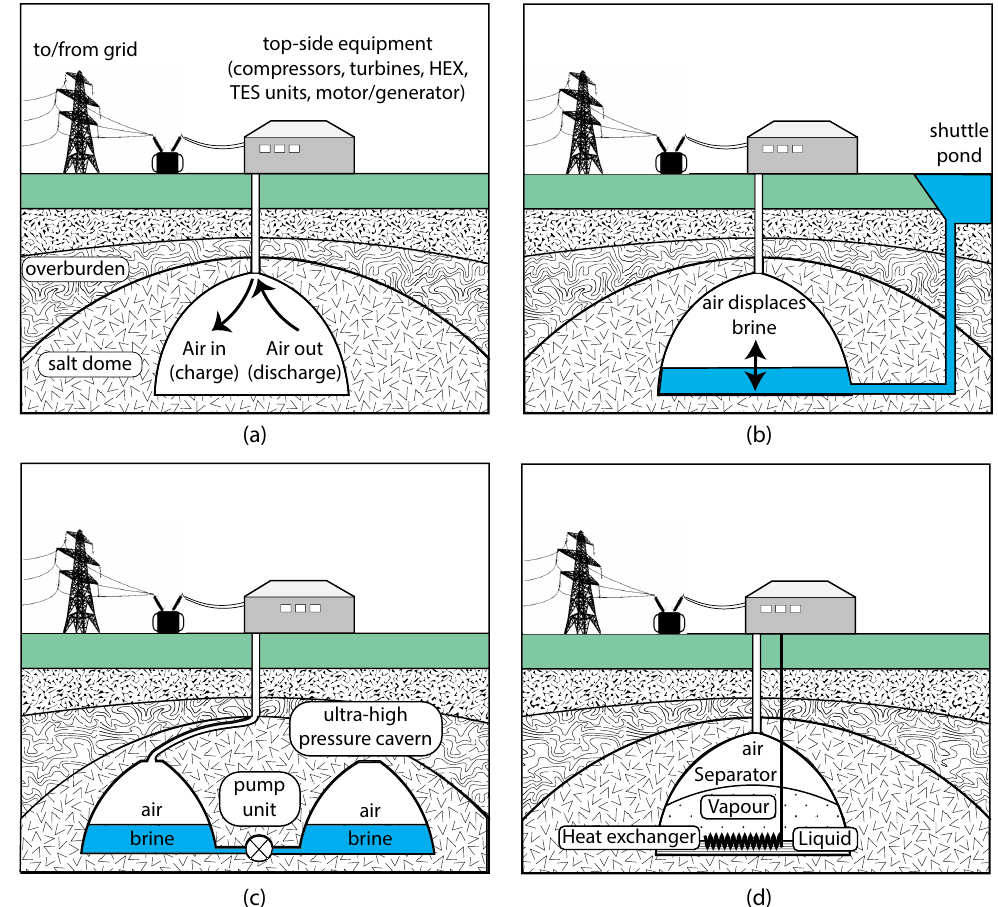
Figure 1. Four primary mechanisms for air storage in ACAES. ( a ) Isochoric storage in a constant volume underground salt cavern. ( b ) Isobaric storage with a shuttle pond. ( c ) Isobaric storage with hydraulic compensation using a pump to regulate the fluid pressure. ( d ) Isobaric storage using the liquid-vapour phase change in a volatile